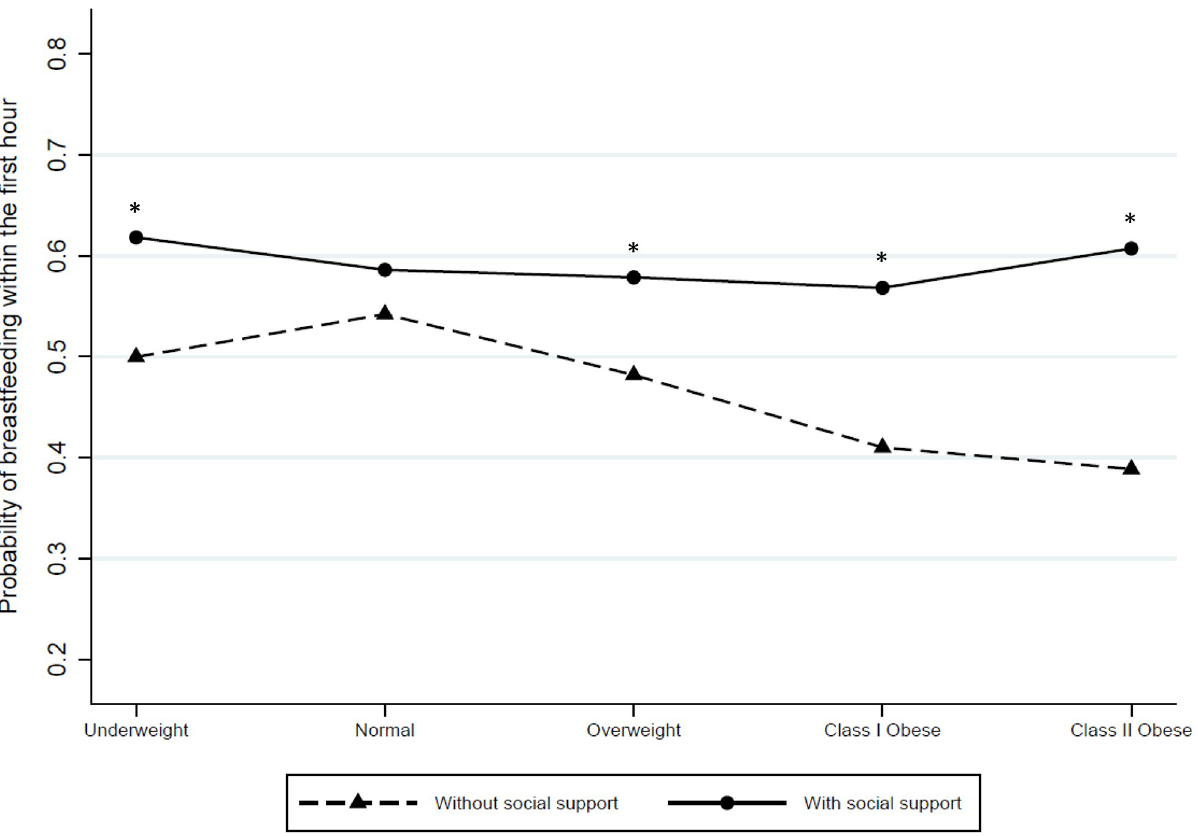
Fig 1. Predicted probabilities of breastfeeding within the first hour according to pre-gestational BMI and social support status. � Denotes subgroups statistical differences.